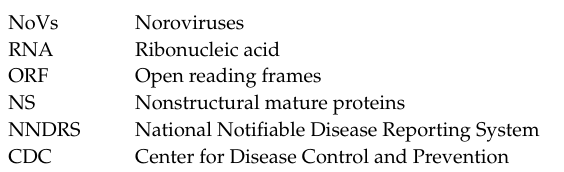
Table S1: Accession numbers of human norovirus sequences used in this study isolated in China during 2004 to 2015 ( n =